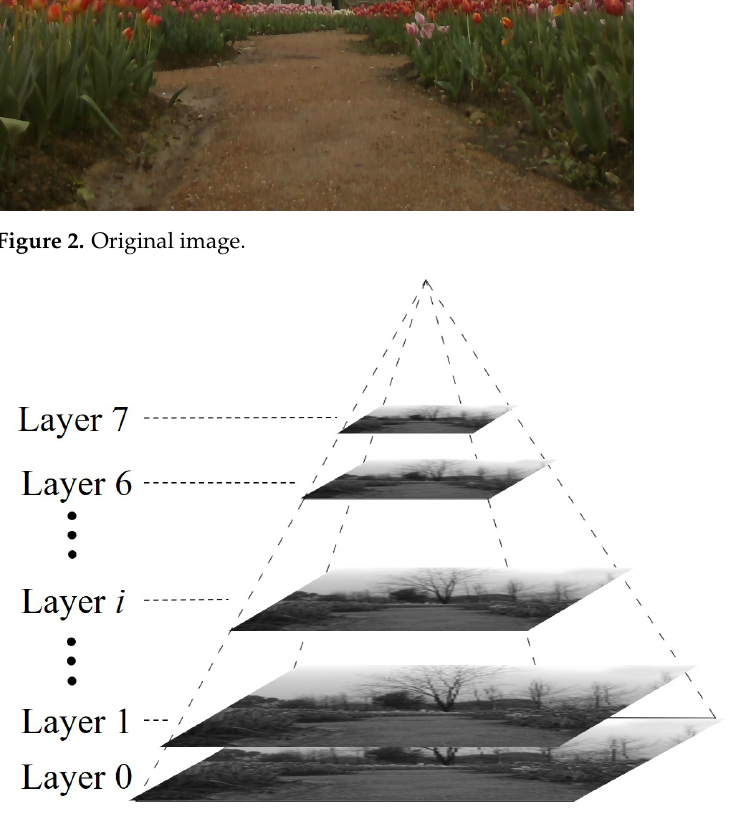
Figure 3. Gaussian image